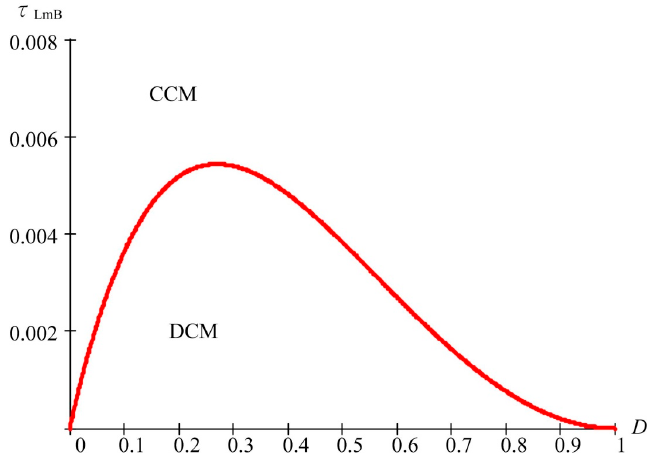
Figure 8. Duty ratio versus τ (cid:3013)(cid:3040)(cid:3003) at boundary condition of the proposed converter under n = 3.